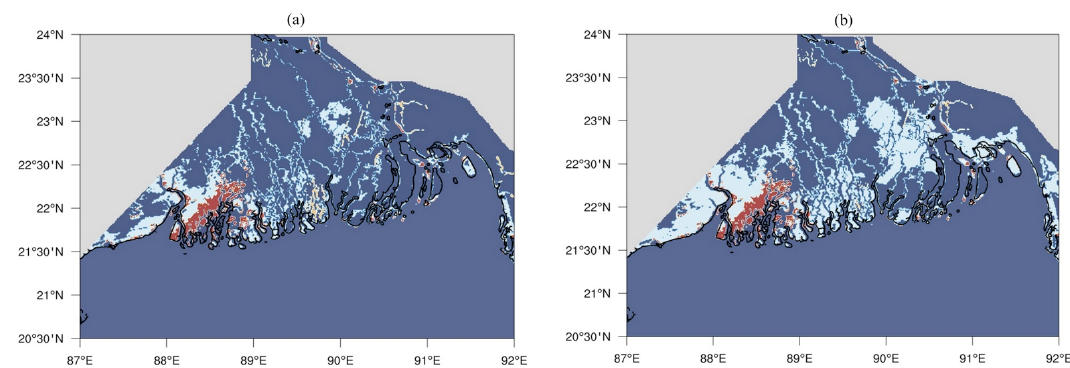
Figure 8. Comparison of inundated areas for TC Aila between the present day and end-21st-century (0.54m SLR) scenario. White represents the flooded areas that were not in the present-day scenario but were flooded due to future SLR. Red shows the inundated area that is similar both for present-day and future scenario case. Blue areas are either land or constant waters (those which are already water at the model initialization time). Panel (a) represents the inundated area when SLR was considered on ocean depths instead of adding it to the open ocean boundary and (b) shows the inundated area when we considered the SLR on the ocean